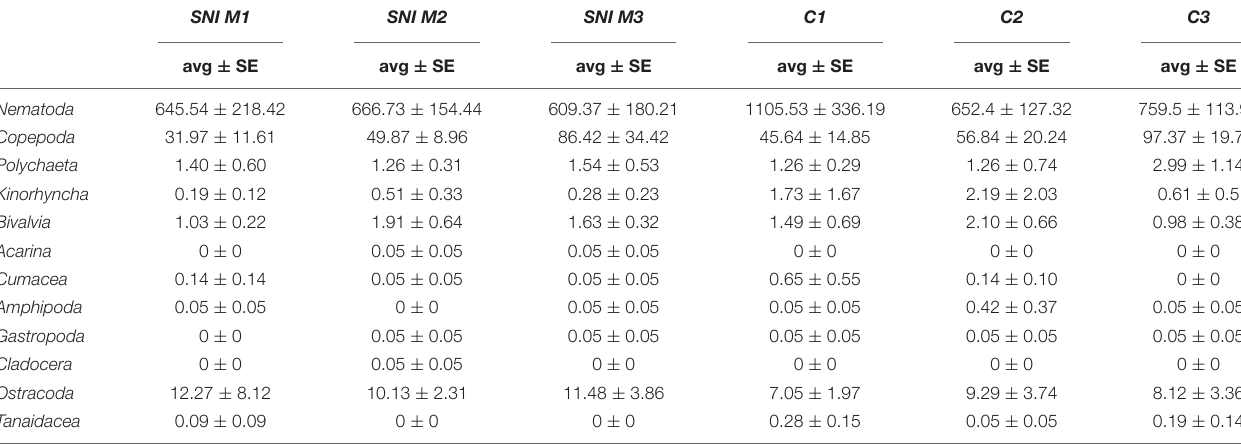
TABLE 2 | List of meiofaunal taxa identified in the SNI and control transects and their average abundance. SNI M1 SNI